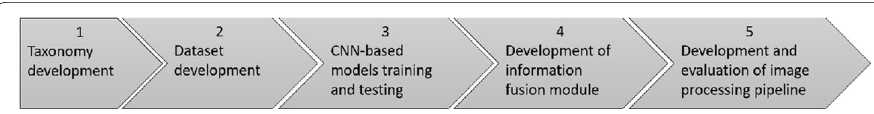
Fig. 1 Main steps of the proposed